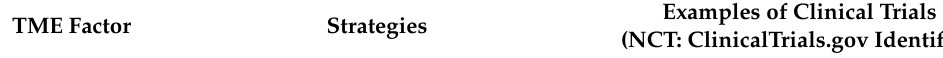
Table 2. Strategies to overcome the inhibitory e ff ects of